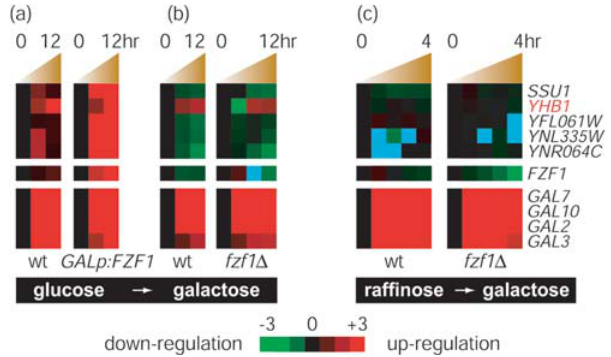
Figure 3. The change of gene expression in Fzf1p response clusters, FZF1 and galactose utilization genes in response to galactose. (a) Wild type and gal promoter driven FZF1 over-expression strains in response to the change from glucose to galactose (experiment E2). (b) Wild type and fzf1 D strains in response to the change from glucose to galactose (experiment E3). (c) Wild type and fzf1 D strains in response to the change from raffinose to galactose (experiment E4). Color unit is fold change of gene expression. Gene expression too low to be detected is colored in blue.